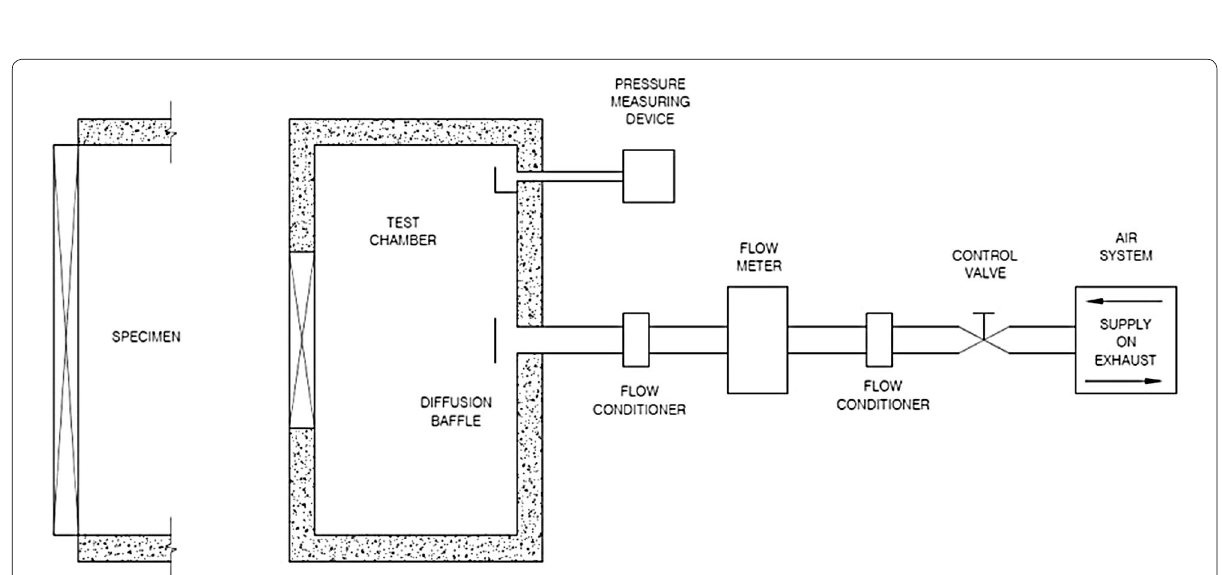
Fig. 6 General arrangement of the air leakage test